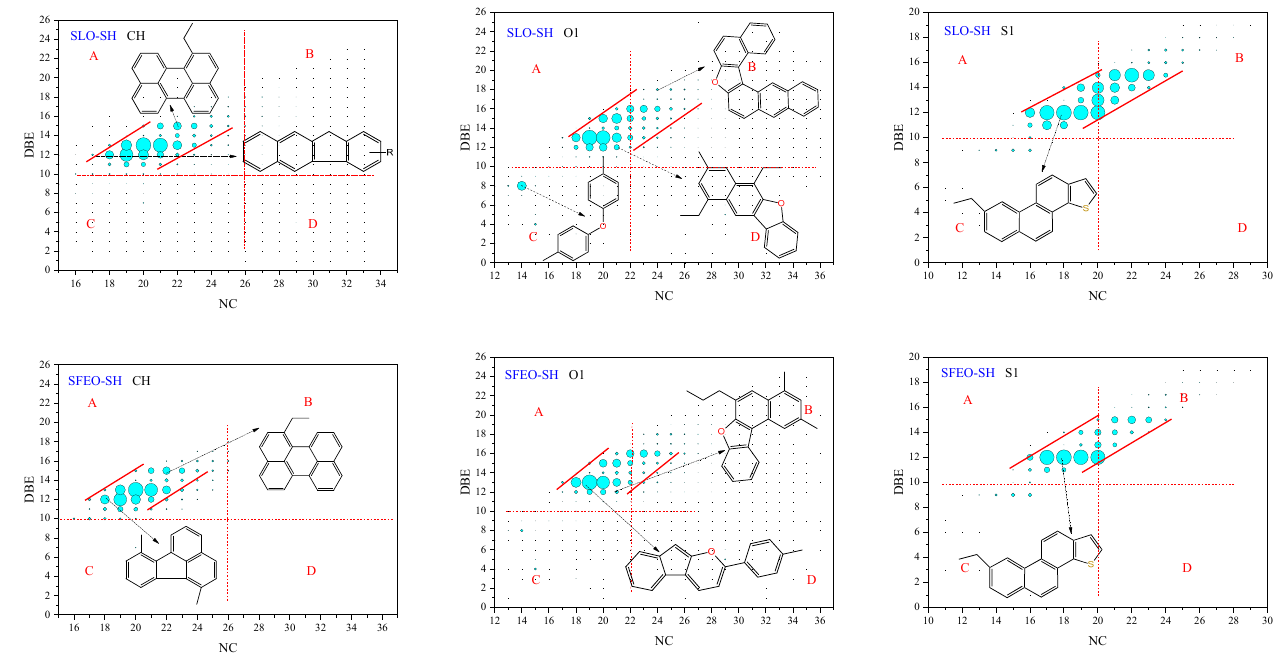
Figure 8. NC-DBE distribution of compounds in SLO–SH and SFEO–SH(APPI). (NC, number of carbon; DBE, double bond equivalents, The NC and DBE regions of CH, O1 and S1 compounds are demarcated at 26, 22, and 20, respectively. The DBE regions of CH, O1, and S1 compounds are demarcated at 10. For example, CH compounds in the A region (NC < 26 and DBE > 10)).